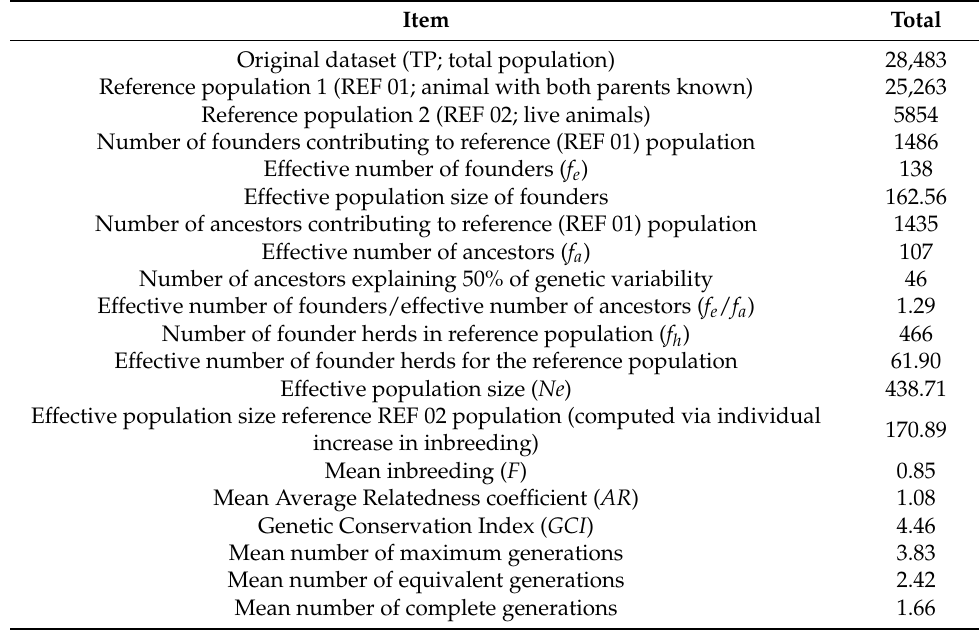
Table 1. Investigated CPH population size and genetic diversity indices.